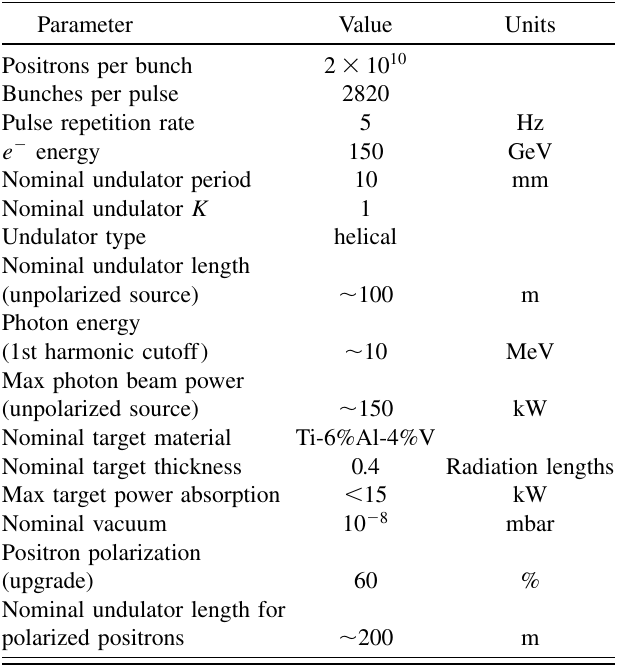
TABLE I. Nominal positron source parameters.